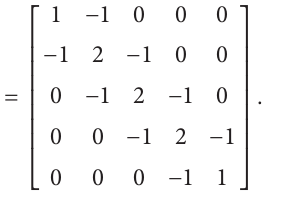
Figure 7: The trajectories of missiles.